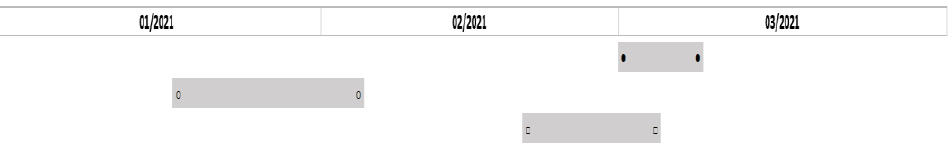
Figure 4. Timeline of the prevalence of Serratia marcescens clones throughout the study duration. The grey rectangles represent 3 clonal groups of Serratia marcescens based on their similarity. Isolates are represented by signs ● ○ □.